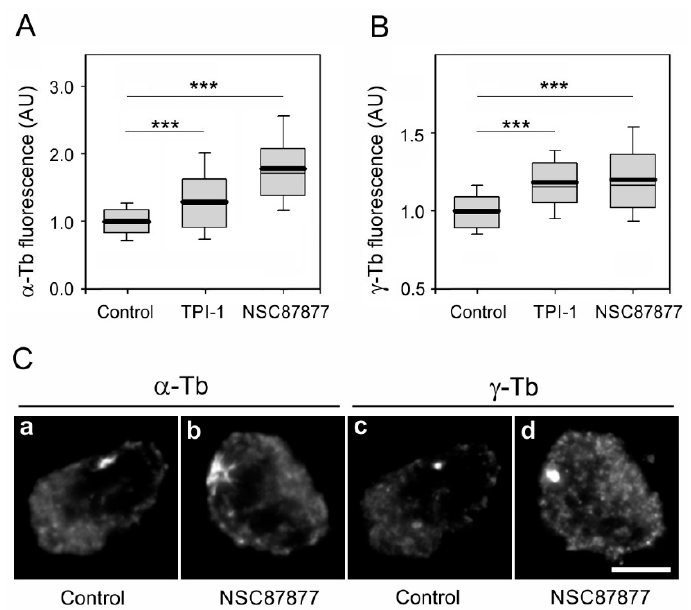
Figure 8. The inhibition of SHP-1 activity augments microtubule nucleation. ( A , B ) BMMCs were cultivated with 100 nM TPI-1, 500 nM NSC87877, or a DMSO carrier (Control) for 1 h before and during the microtubule regrowth assay. The distribution of α -tubulin or γ -tubulin fluorescence intensities (arbitrary units (AU)) in 1- µ m ROI at 1.5 min of regrowth is shown as box plots (three independent experiments, > 50 cells counted for each experimental condition). ( A ) The box plot of α -tubulin fluorescence intensities in TPI-1 ( n = 158) or NSC87877 ( n = 158) preincubated cells relative to the control cells (Control, n = 158). ( B ) The box plot of γ -tubulin fluorescence intensities in TPI-1 ( n = 158) or NSC87877 (n = 158) preincubated cells relative to the control cells (Control, n = 158). The bold and thin lines within the box represent the mean and median (the 50th percentile), respectively. The bottom and top of the box represent the 25th and 75th percentiles. The whiskers below and above the box indicate the 10th and 90th percentiles. *** p < 0.00001. ( C ) The labeling of α -tubulin and γ -tubulin in the microtubule regrowth experiment in control cells with a DMSO carrier (Control; a , c ) and cells pretreated with 500 nM NSC87877 for 1 h before and during the microtubule regrowth assay ( b , d ). The cells were fixed with F / Tx / M at 1.5 min of regrowth. The pairs of images Figure 8a,b and Figure 8c,d were collected and processed in exactly the same manner. Scale bar, 5 µm.